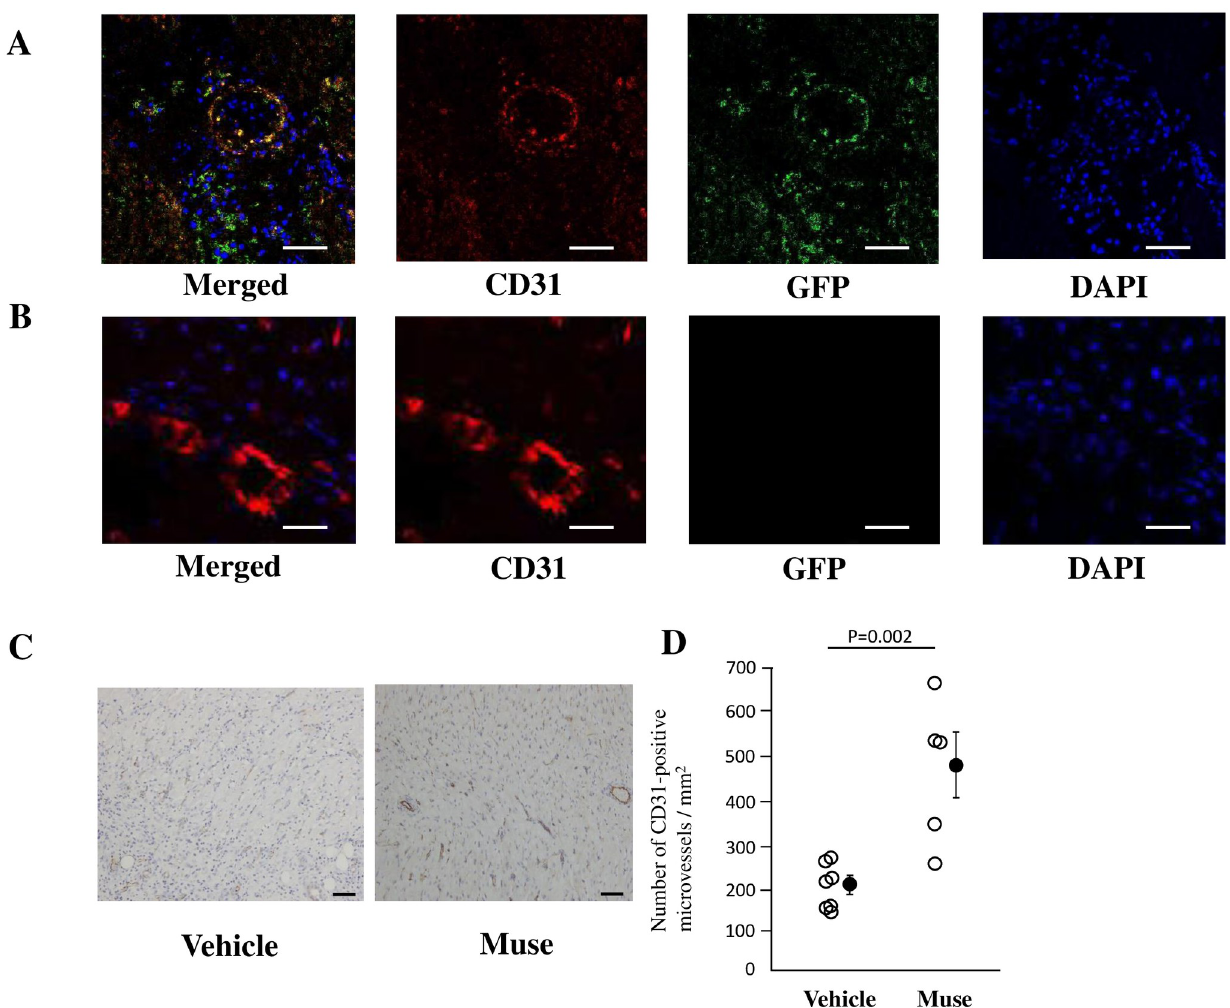
Fig 3. Differentiation of Muse cells into vessels. A: GFP-labelled Muse cells and CD31-positive microvessels in the infarct border area. GFP (green) and CD31 (Red) are merged, suggesting that GFP-labelled Muse cells differentiated into vascular endothelium. Bar = 50 μ m. B: Negative control in the infarct border area. CD31 (red), DAPI (blue), Bar = 25 μ m. C: Typical pictures of CD31-positive microvessels by immunohistological staining in the Vehicle and Muse groups. Bars = 50 μ m. D: The number of CD31-positive microvessels by immunohistological staining is significantly greater in the Muse (n = 5) group than in the Vehicle (n = 7)